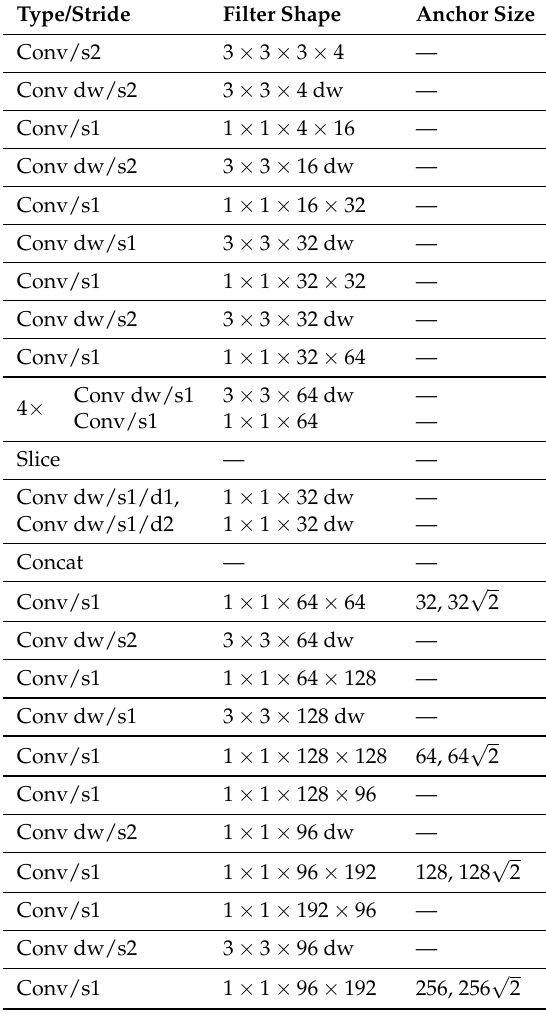
Table 2. Architecture of the backbone of